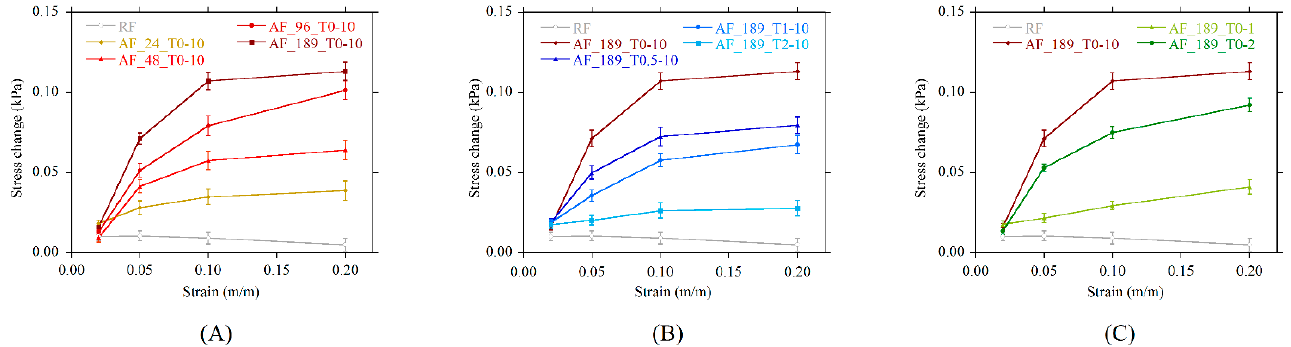
Figure 10. Stress change under magnetic field versus prestrain as a function of ( A ) magnetic field strength, ( B ) switch-on time, ( C ) switch-off time.